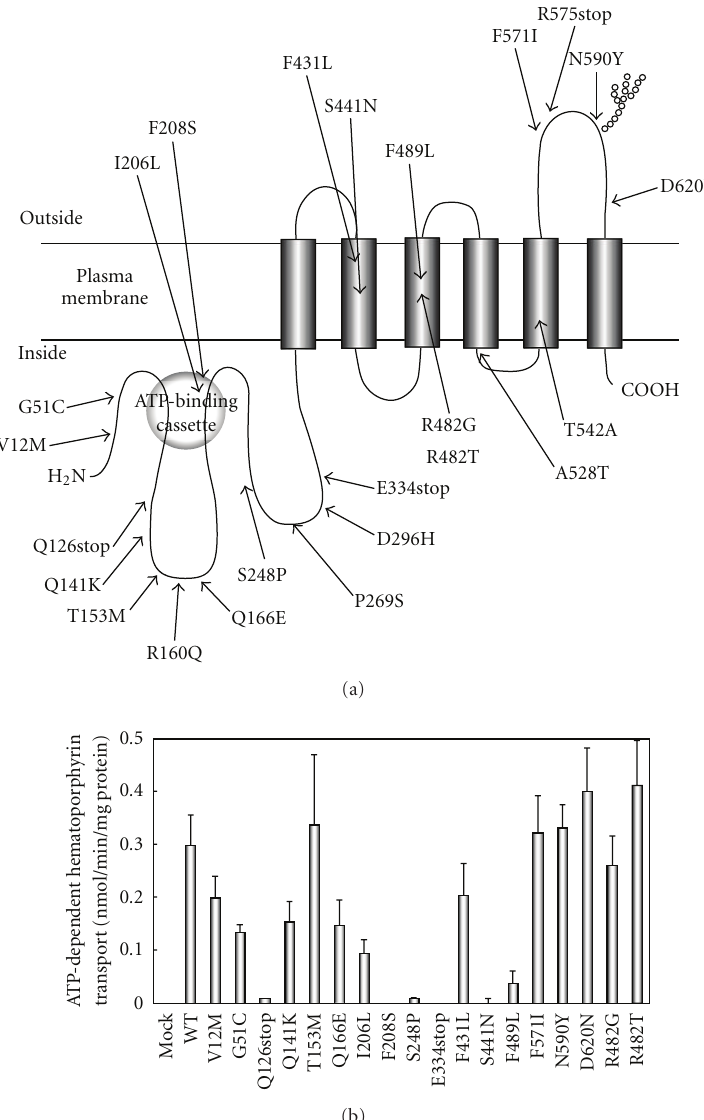
Figure 4: (a) Schematic illustration of human ABCG2 and its nonsynonymous polymorphisms. SNP data on the polymorphisms of ABCG2 were obtained from the NCBI dbSNP database and recent publications. The variants R482G and R482T are acquired mutations. (b) ATP- dependent transport of hematoporphyrin by ABCG2 and its variants. Plasma membrane vesicles expressing ABCG2 variants (50 μ g of protein) were incubated with 20 μ M hematoporphyrin in the presence or absence of 1mM ATP in the standard incubation medium at 37 ◦ C for 10 minutes. The ATP-dependent transport of hematoporphyrin is normalized for the amount of ABCG2 protein. Data are from